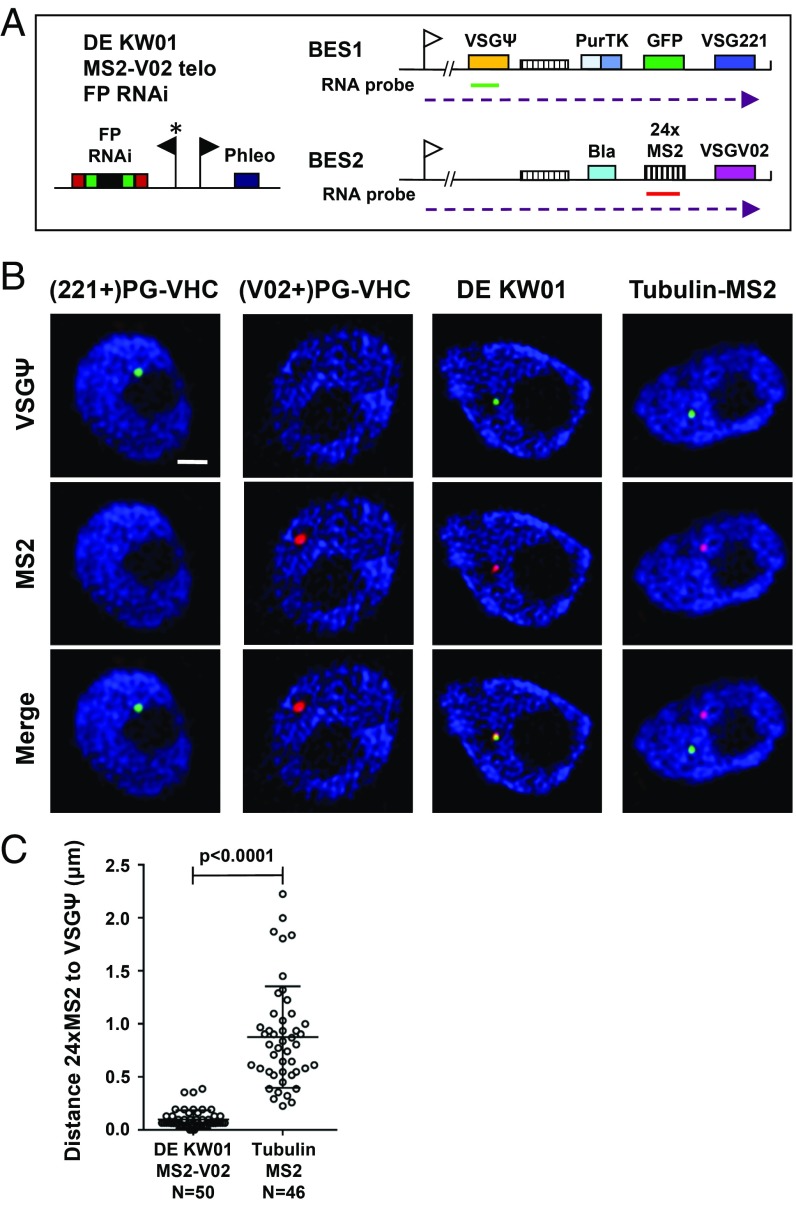
Simultaneous transcription of 2 unstably active ESs in the same subnuclear location in double-expresser DE KW01 cells. (A) Schematic of the DE KW01 MS2-V02 telo FP-RNAi cell line used for the RNA FISH experiments. This line contains a construct with a 24× MS2 repeat cassette linked to a blasticidin resistance gene (bla) integrated immediately upstream of the VSGV02 gene. Stellaris RNA FISH probes are indicated, with 1 set hybridizing with the VSGΨ in BES1 (green line) and the other set hybridizing with the MS2 repeat sequence in BES2 (red line). Further, the schematic is as described in Fig. 4A. (B) Representative superresolution microscopy images of RNA FISH performed on the single-expresser (221+)PG-VHC or (V02+)PG-VHC cell lines compared with the double-expresser DE KW01. A cell line containing MS2 repeats in the tubulin locus (Tubulin-MS2) is included as a control. Experiments using probes against the VSGΨ (green) or the 24× MS2 repeats (red) are shown, with DNA stained with DAPI (blue). (Scale bar, 500 nm.) (C) Quantitation of the distance between nascent VSGΨ and MS2 repeat containing transcripts using superresolution microscopy. The MS2 repeats are located in BES2 in DE KW01 MS2-V02 or in the tubulin locus (Tubulin-MS2). The average distance is shown ± SD with the significance of colocalization indicated with a P value.